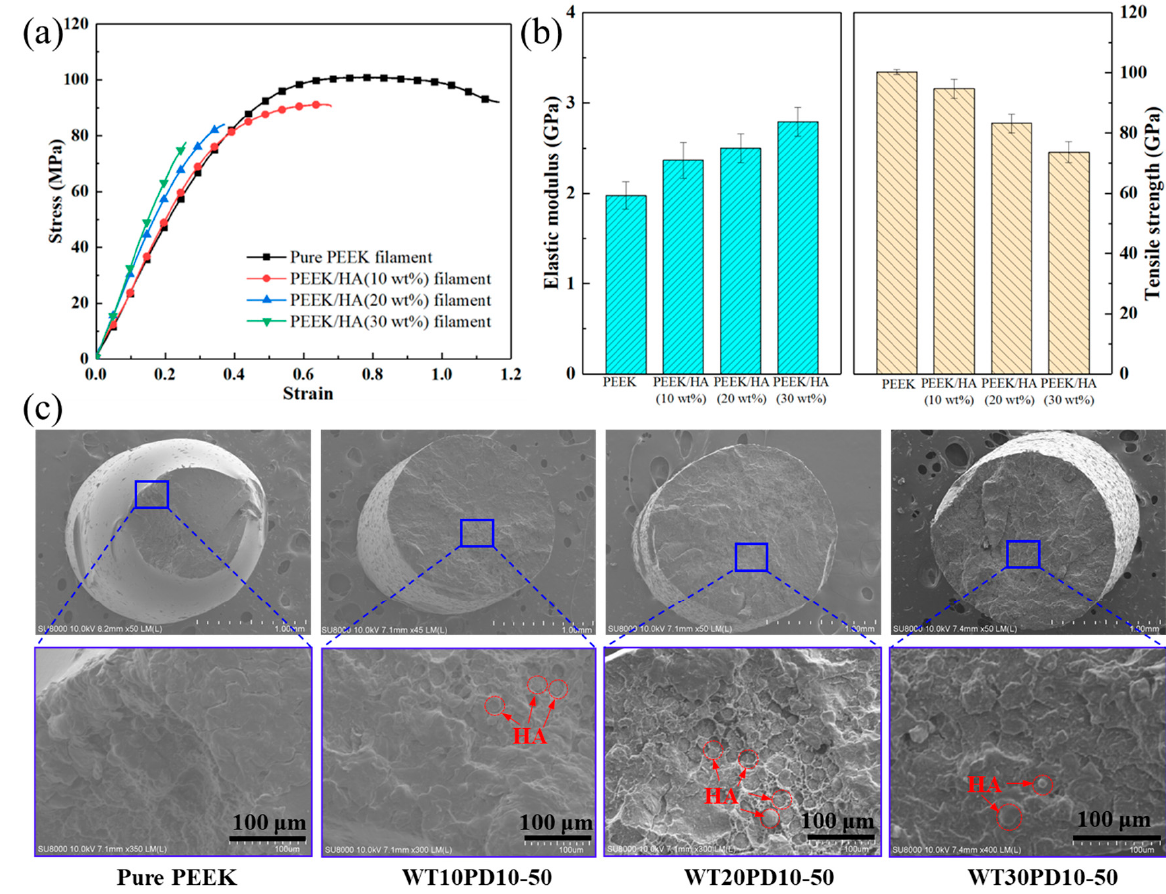
Figure 4. Tensile mechanical properties of composite filaments: ( a ) stress–strain curve; ( b ) elastic modulus and tensile strength; ( c ) SEM of fracture surface.